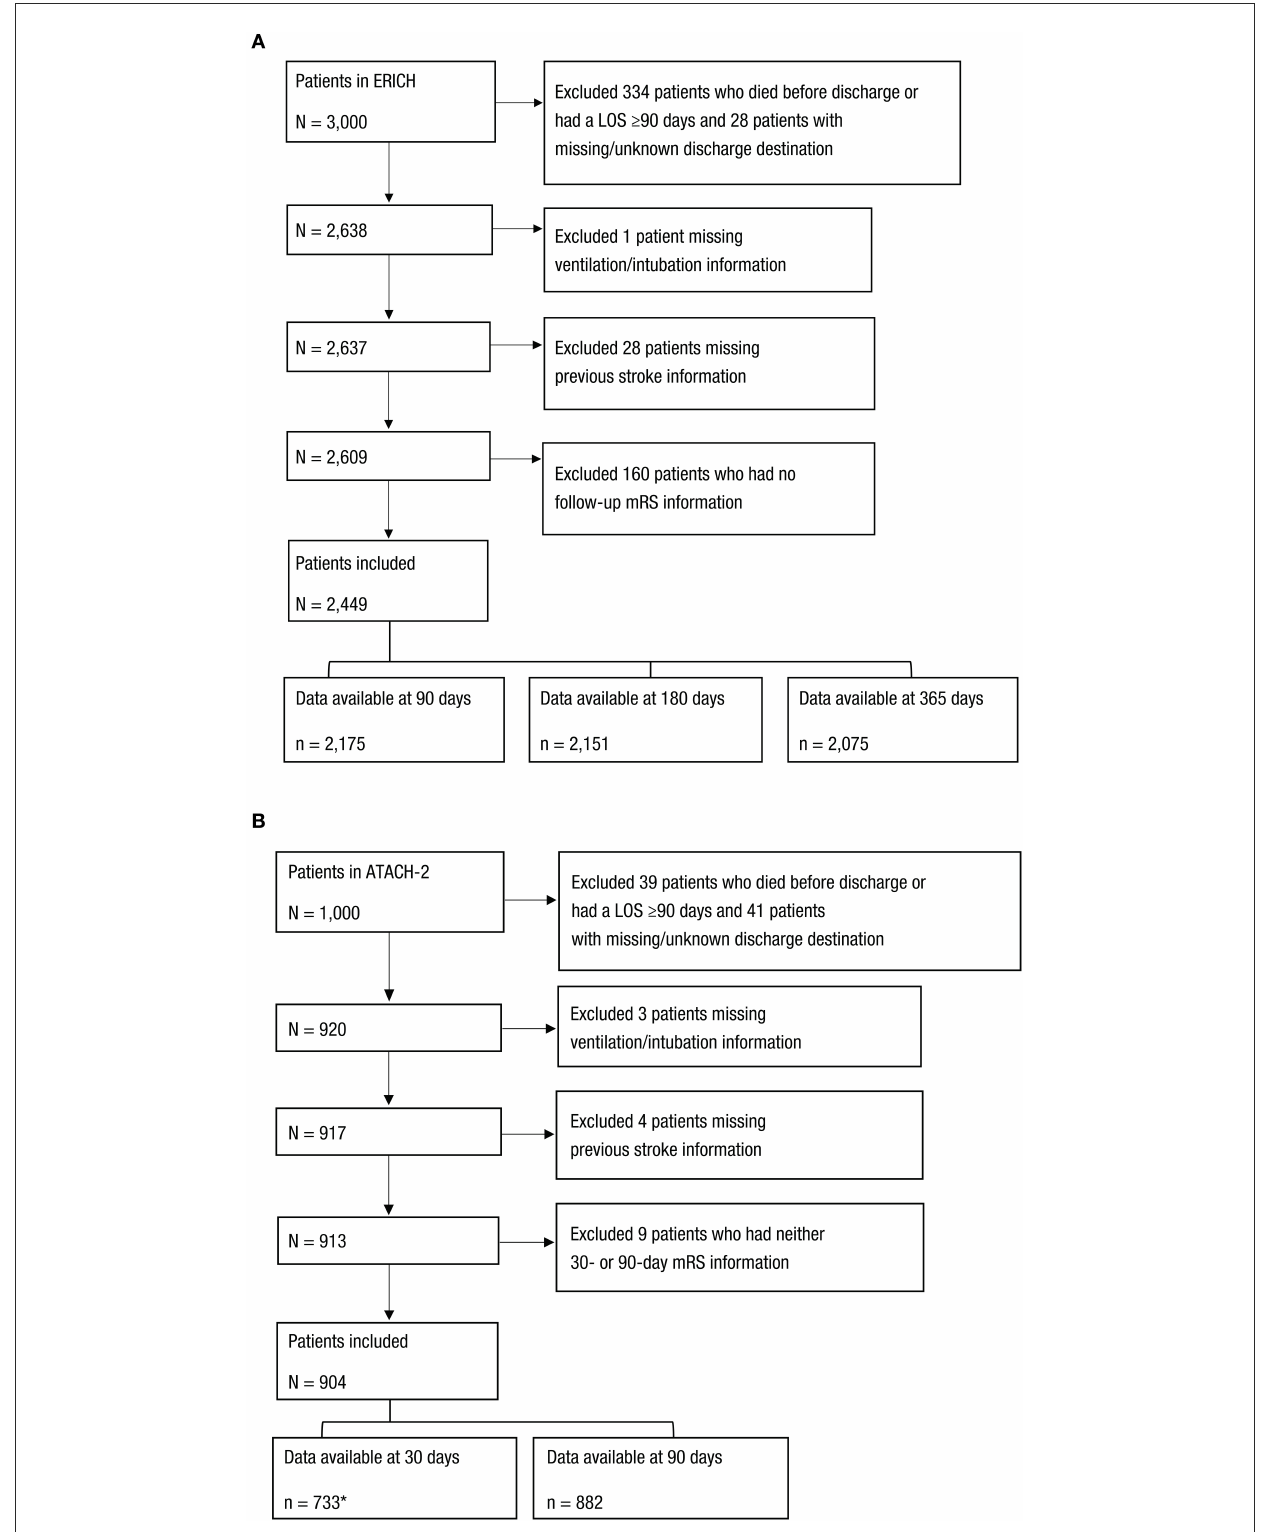
FIGURE1 Selection of Patients From the (A) ERICH and (B) ATACH-2 Studies. *Excluded patients with a LOS ≥ 30 days. LOS, length of stay; mRS, modified Rankin